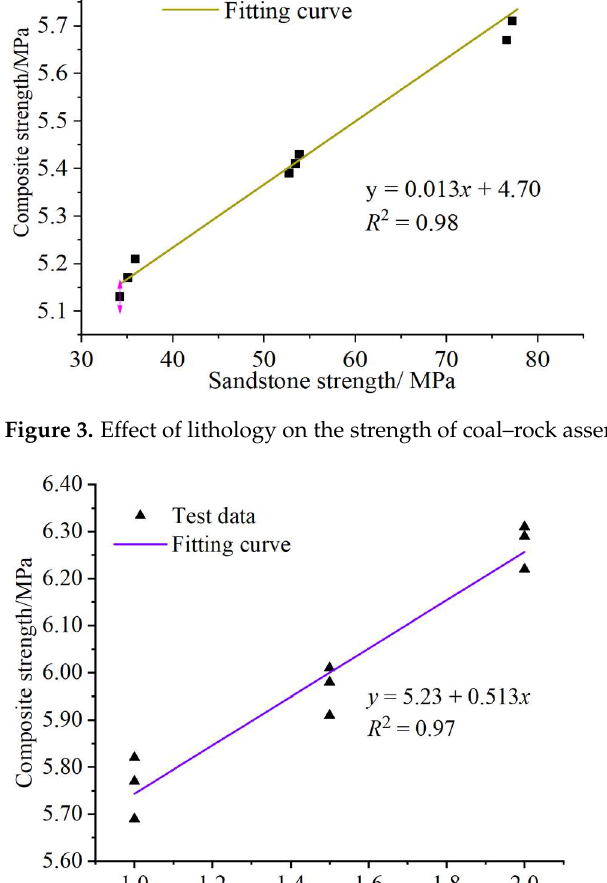
Figure 3. Effect of lithology on the strength of coal–rock assemblages.